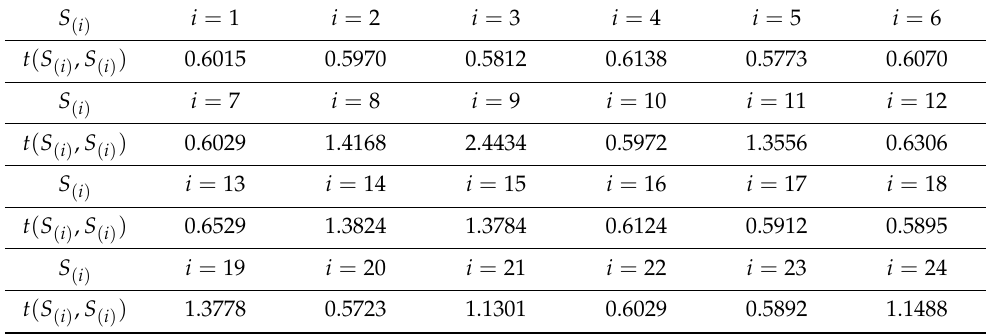
Table 2. The output result of each scenic spot’s average dissimilarity (four decimal places).